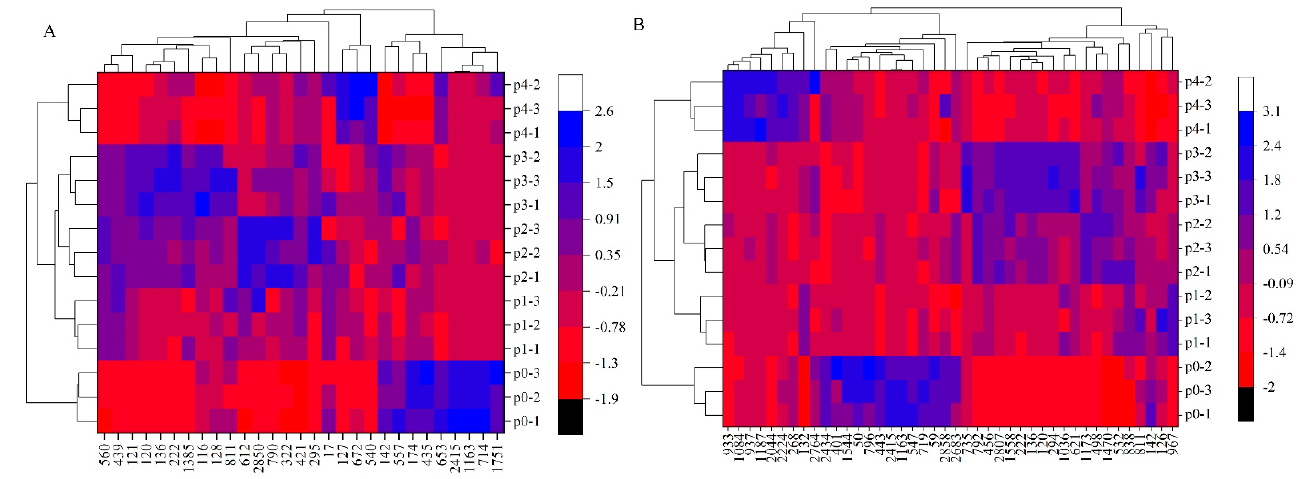
Figure 4. Thermographic analysis of differential metabolites in the metabolic pathways of ( A ) amino acid biosynthesis and ( B ) ABC transporter biosynthesis.